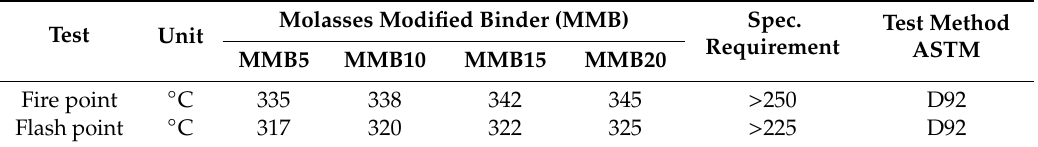
Table 4. Fire point and Flash point test results of MMBs containing molasses with 5.2% water